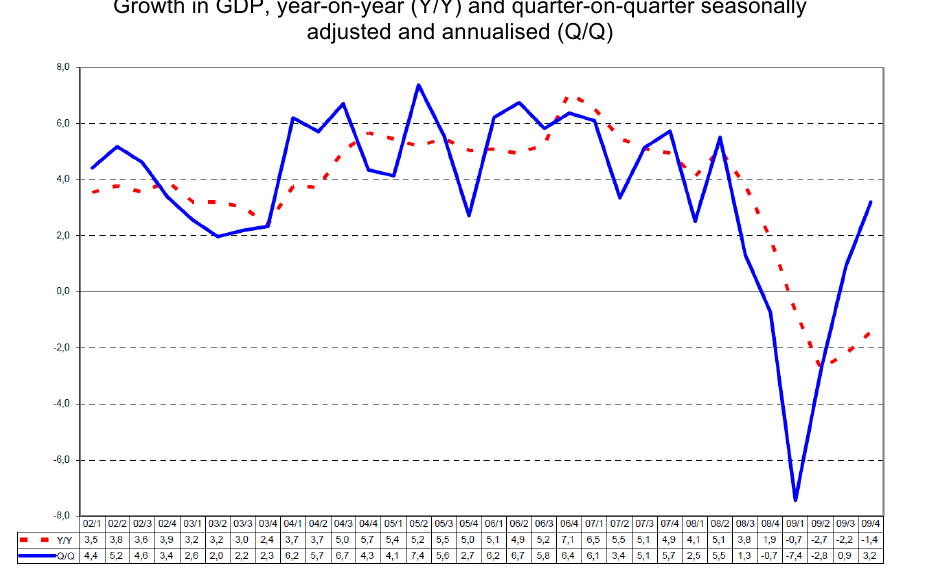
Growth in GDP, year-on-year (Y/Y) and quarter-on-quarter seasonally adjusted and annualised